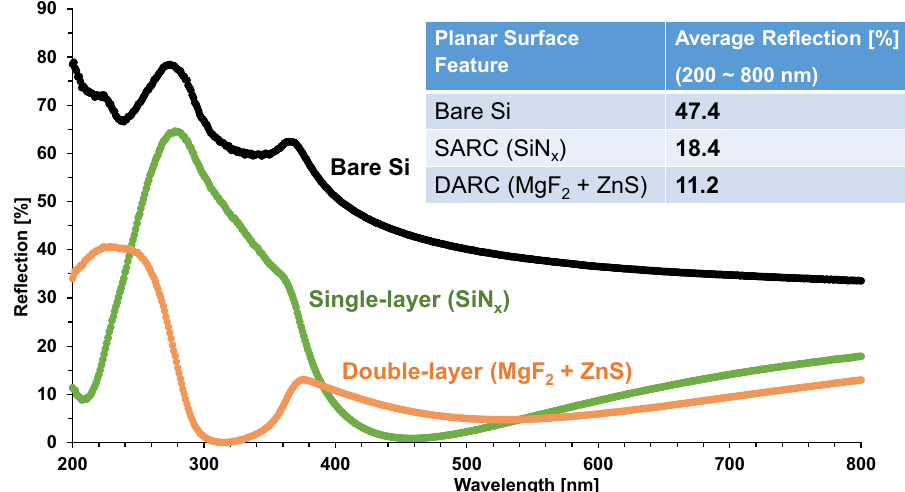
Figure 4. Reflection comparison of SiN x as single-layer ARC (SARC) and MgF 2 /ZnS as a double-layer ARC (DARC) on planar silicon surface. The insert table lists the average reflection obtained from the measurement results.